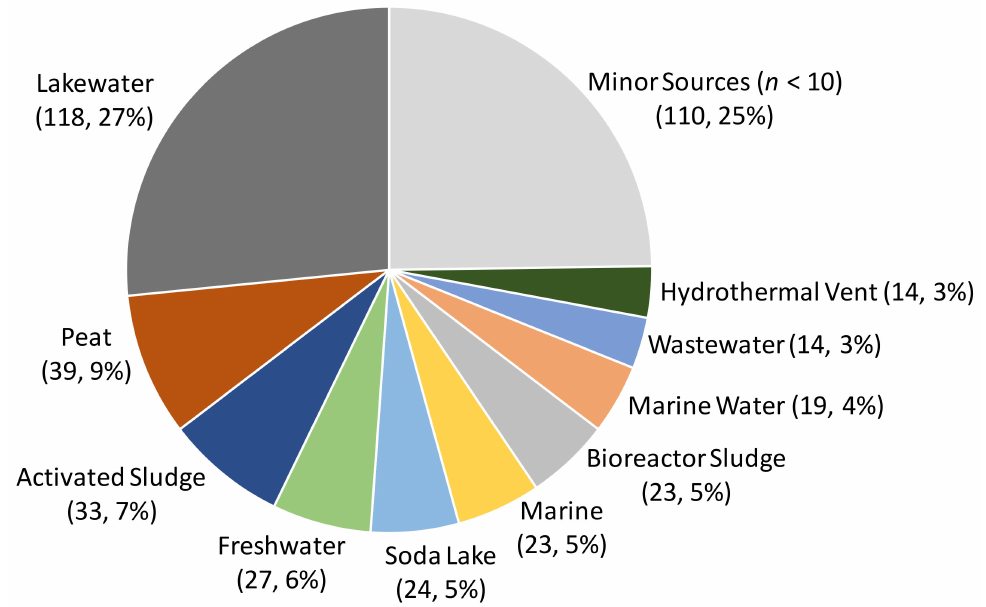
Figure 3. Sources of samples from which myxobacterial 444 MAGs have been derived. The ten sources which have yielded the largest numbers of MAGs are indicated.